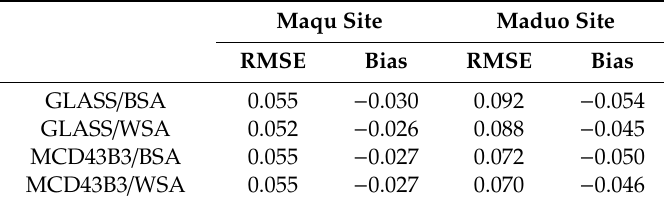
Figure 3. Taylor diagrams of the statistics of the 8-day average albedo of surface albedo products and ground-based observation at ( a ) Maqu and ( b ) Maduo sites.